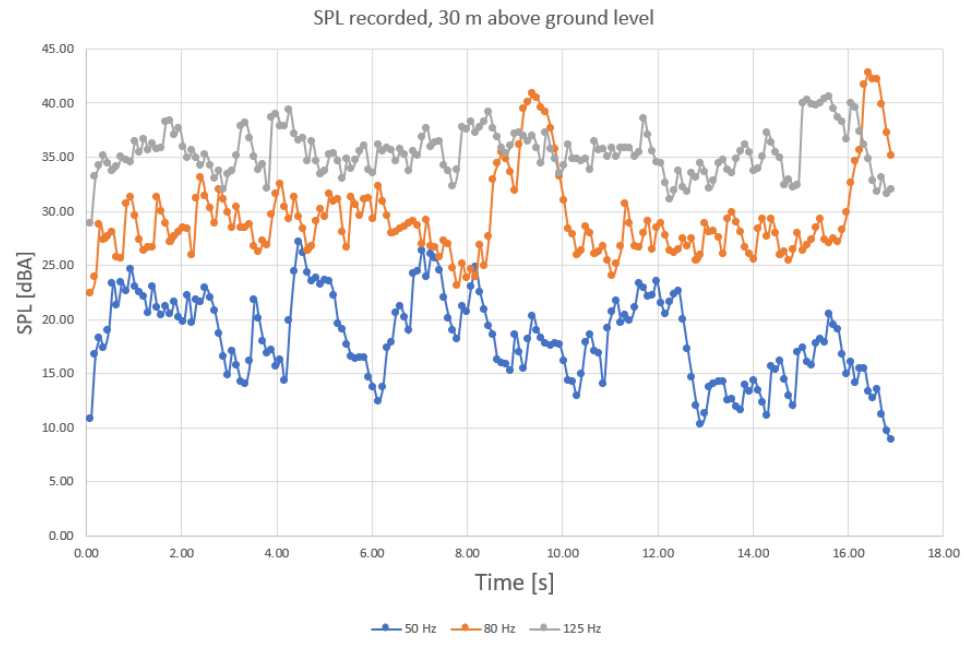
Figure 8. SPL recorded for higher frequency range, ground level (at 50 Hz, 80 Hz, and 125 Hz, with blue—50 Hz, orange—80 Hz, and grey—125 Hz components).